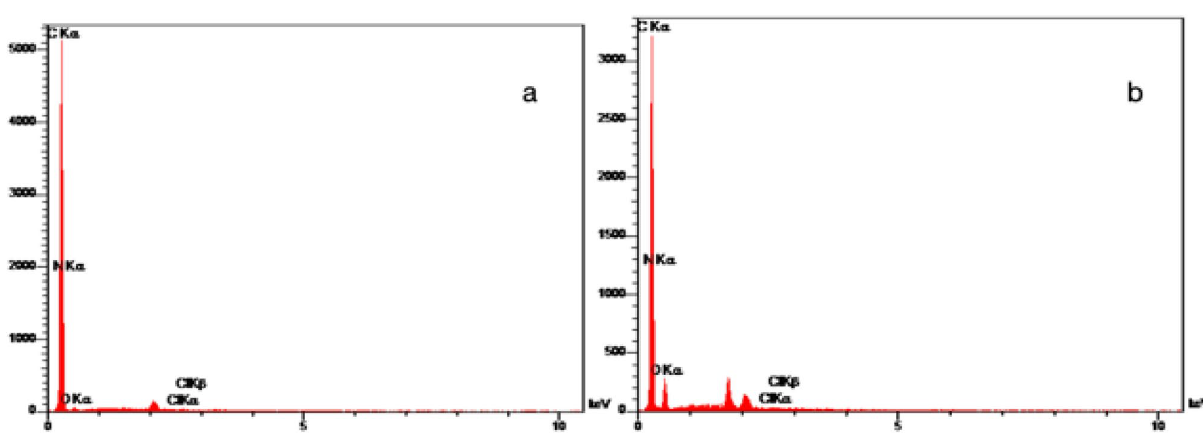
Figure 2. The EDX spectrum of ( a ) F + B and ( b ) F + B + P PP